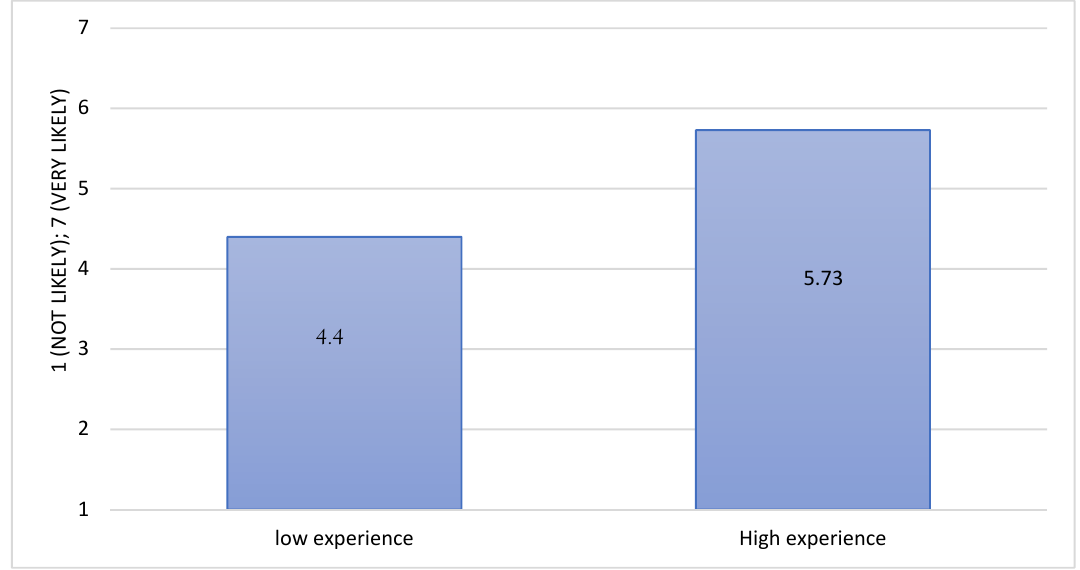
Agronomy 2021 , 11 , x FOR PEER REVIEW Figure 10. Probability of adopting agroecological practices in the future depending on the size of the farm.